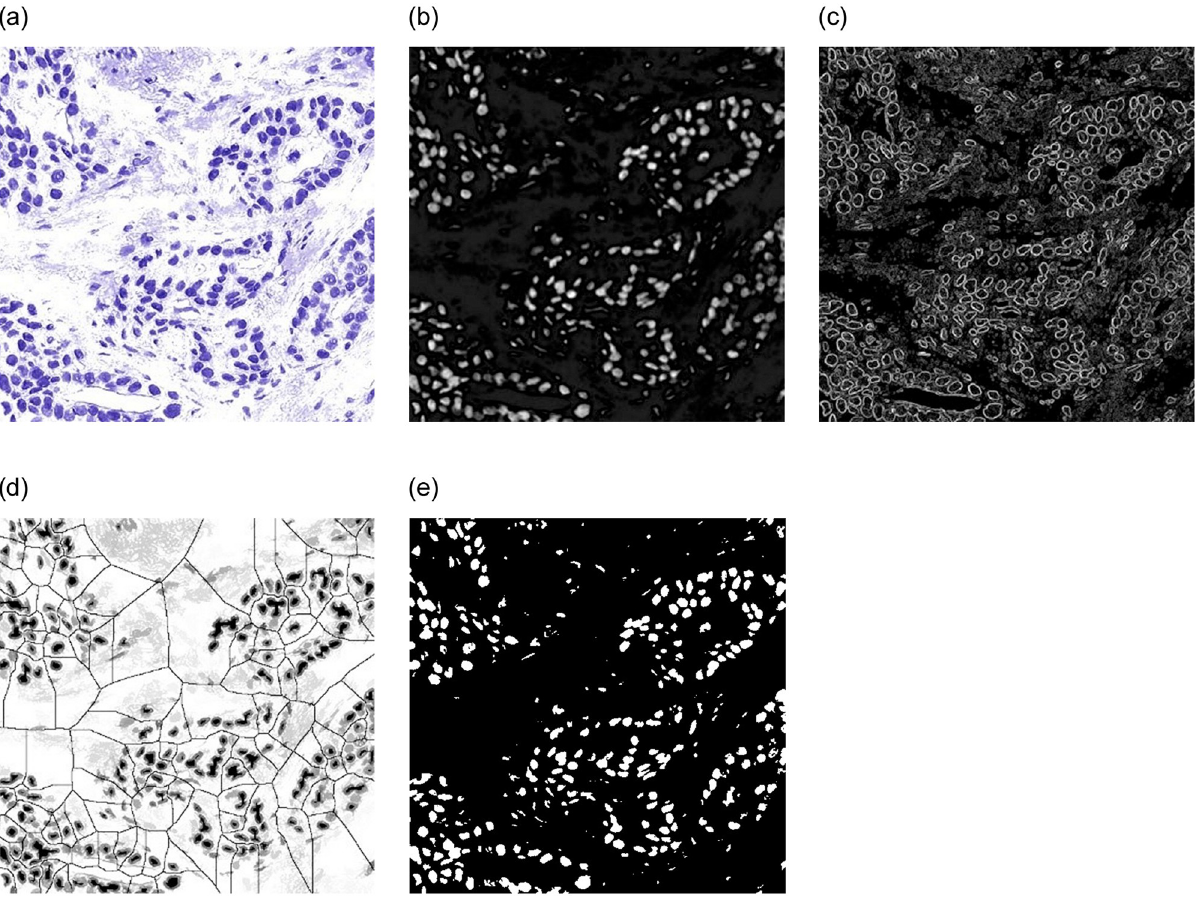
Fig 5. Visualization of two-stage nuclei segmentation. (a) Stain separation image, (b) Salient Region Detection, (c) Gradient amplitude image, (d) Marked image, (e) Nuclei segmentation image.